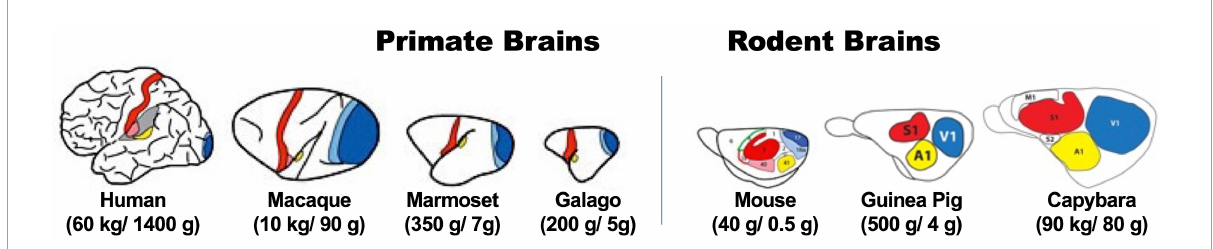
FIGURE1 Diagrams illustrating different organization principle between primates (left) and rodents (right) by comparing brain structures of species with different body weight and brain sizes within respective mammalian order. Colored areas in brain illustrations indicate primary sensory (red for somatosensory, blue for visual, and yellow for auditory) areas in representative extant primate (left) and rodent (right) species of body (first numbers in brackets) and brain (last numbers in brackets) sizes (adopted and modified from Krubitzer, 2009; Krubitzer and Dooley, 2013). Note the difference in proportion of these primary areas and association areas (in white) in different sized-brain between primates and rodents. ( Ref. color symbols not directly related to the scope of this article, but illustrated in the original figures: green, motor area; pink, secondary somatosensory area; light blue, secondary visual